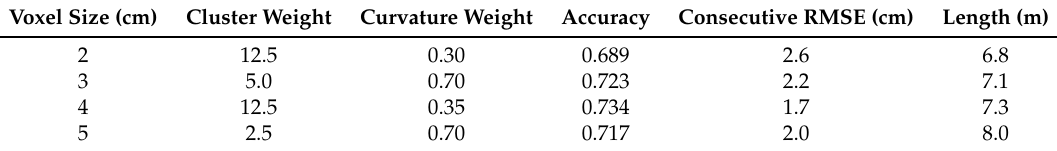
Table 5. Maximum accuracy values for each voxel size and a plot of a radius of 20 m. For this plot radius only, one weight setting per voxel size from the parameter study gave the maximum accuracy